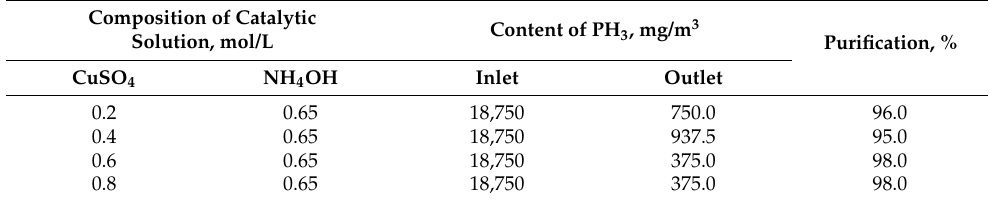
Table 2. The effect of CuSO 4 content on the extent of purification from PH 3 at t = 50 ◦ C, V PH3 = 40